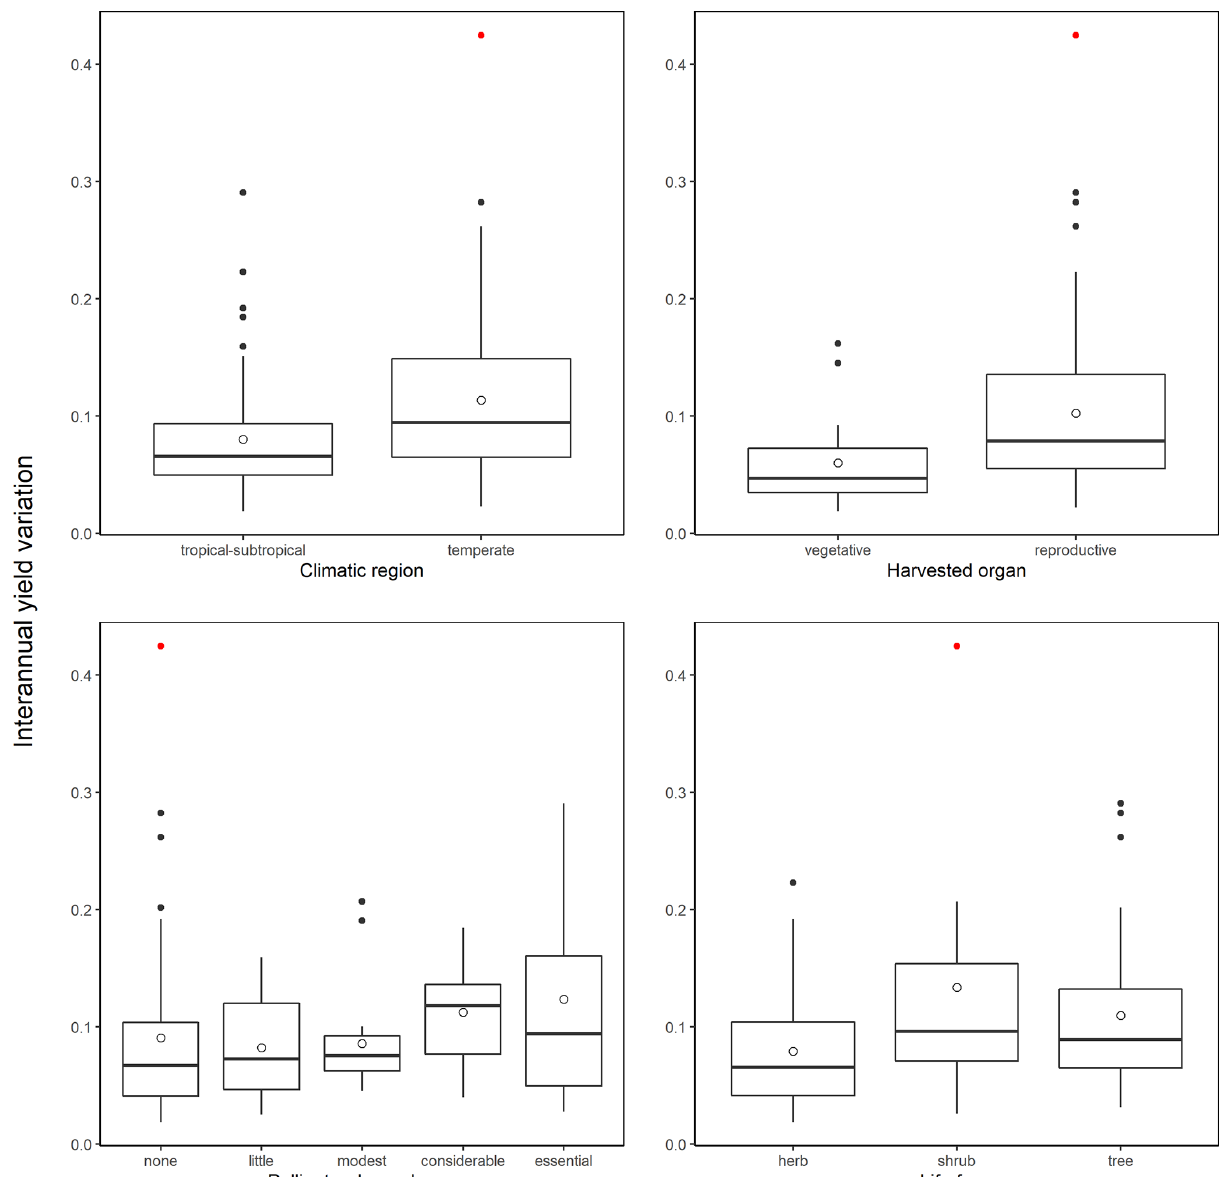
Figure A2. Boxplots showing the distribution of the interannual yield variation against climatic region, type of harvested organ, pollinator dependence, and crop life form. Boxes delimit the lower and upper quartiles; the black horizontal line within the boxes shows the median, the white circle the mean, the vertical lines the whiskers, and the points outside the boxes the outlying points. The red outlying points correspond to the FAO item “jojoba